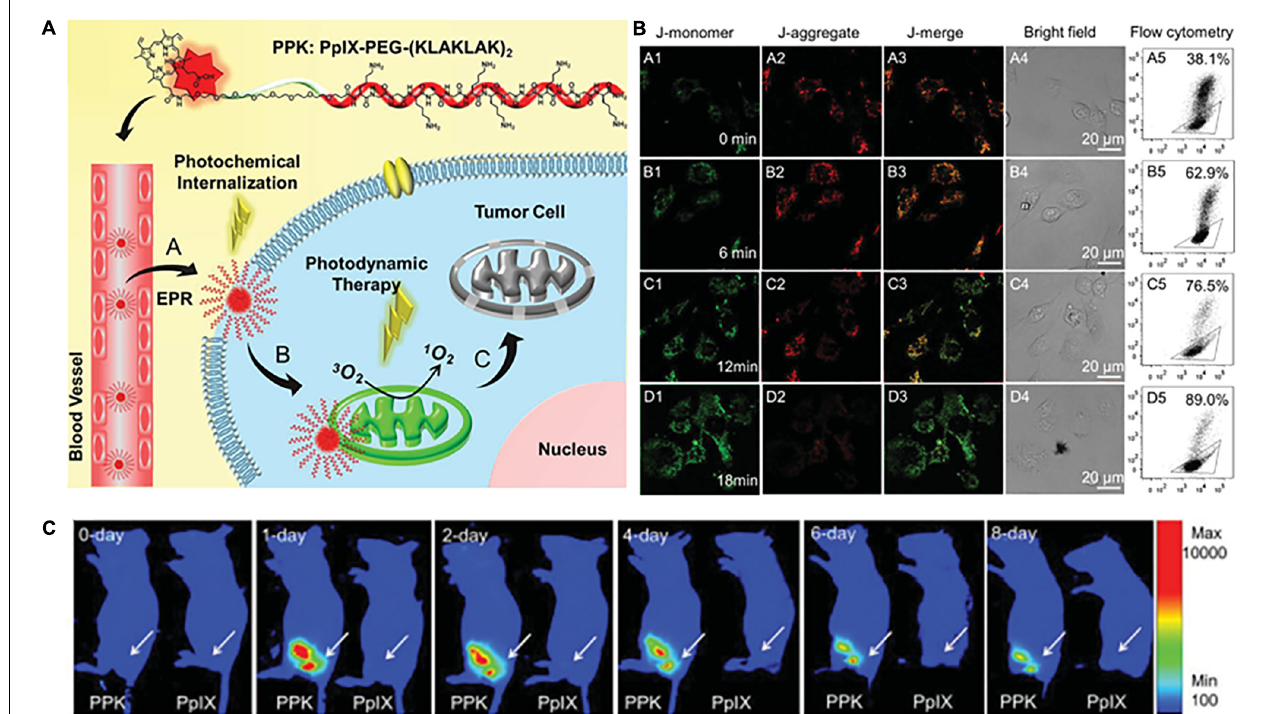
FIGURE 6 | (A) Structure of PPK and schematic diagram of the mitochondria-targeted self-delivery process. Passive targeting to tumor cells and the photochemical internalization (PCI) effect enhanced cellular internalization of PPK under short-duration light irradiation. (B) Mitochondria-targeting mediated by (KLAKLAK) 2 . (C) ROS formation, mitochondrial destruction, and cell death mediated by the synergistic effect between (KLAKLAK) 2 and PpIX under long-duration light irradiation. (B) CLSM images and the corresponding flow cytometric analysis of the mitochondrial membrane potential for HeLa cells when the cells were incubated with 40 µ g mL − 1 of PPK and then exposed to different irradiation durations: (A1–A5) without light irradiation (control); (B1–B5) with 6-min light irradiation; (C1–C5) with 12-min light irradiation; (D1–D5) with 18-min light irradiation. For (A5–D5) , the triangle separates populations with high (inside the triangle) and low (outside the triangle) membrane potential. (C) Intratumoral fluorescence distributions of PpIX and PPK on the 10th day after subcutaneous injection. Images were adapted with permission from reference (Han et al.,